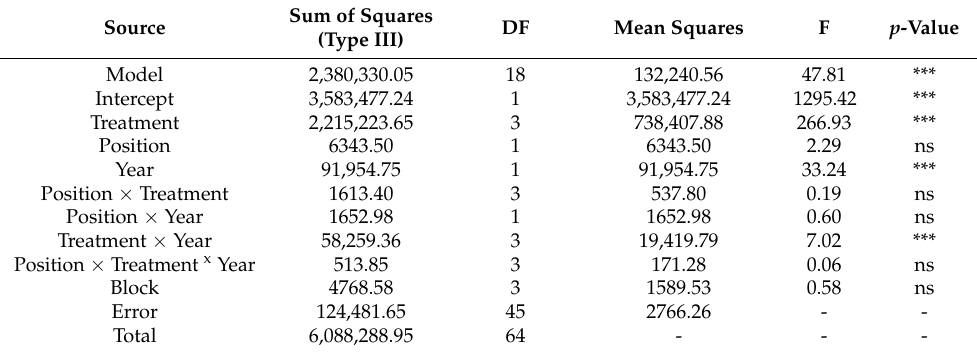
Table A4. Results of general linear model analysis (type III) testing the effects of the independent variable block, treatments, positions, years, and their interaction on weed dry biomass.